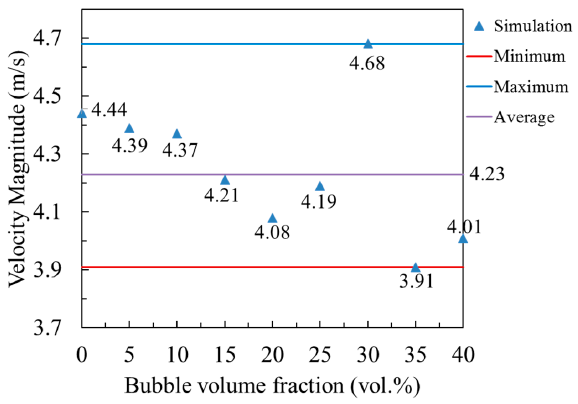
Figure 11. Maximum velocities in the simulations.